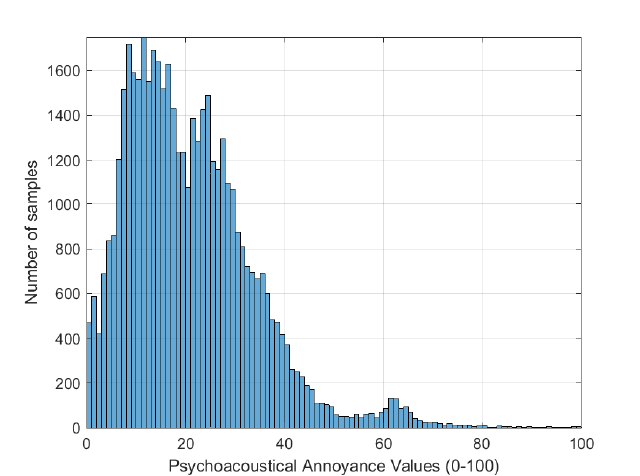
Figure 1. Histogram of PA values in the database.